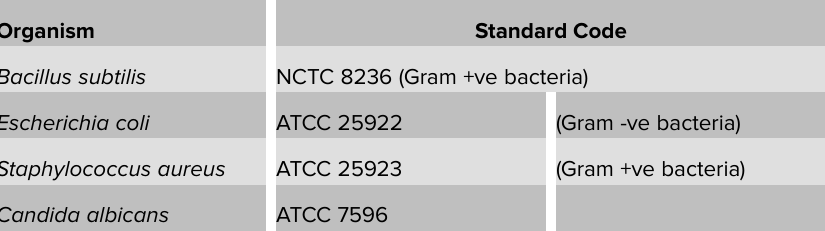
Table 1: The standard microorganism used in the assay.